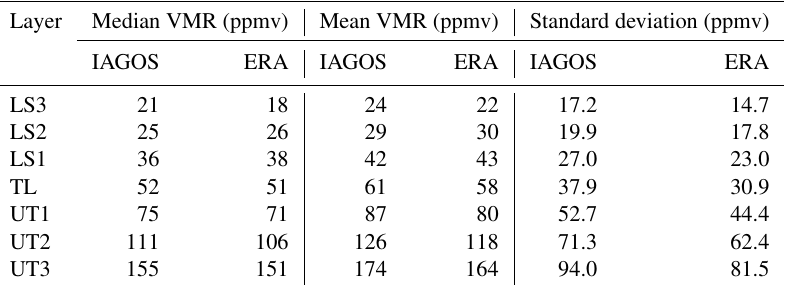
Table 3. Same as Table 2 but for water vapour volume mixing ratio (VMR).